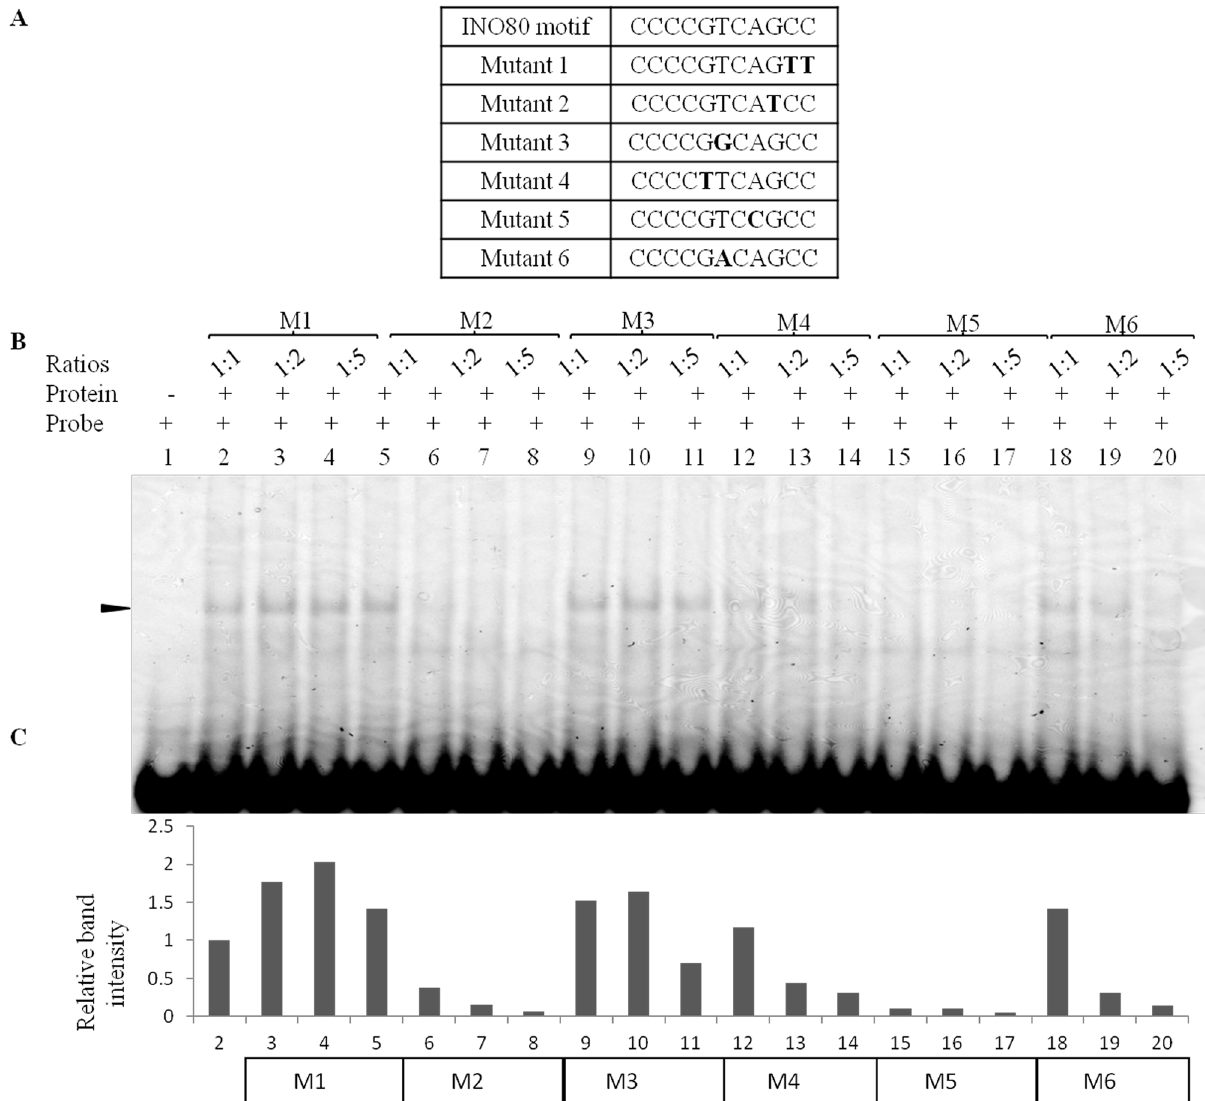
Fig 5. Competitive EMSA with the mutant oligos. (A) List of mutant oligos used in the assays, (B) Results of competitive EMSA with mutant oligos at the indicated ratio, (C) Densitometric scan of gel shown in B. The intensity value of the band (shown by arrow) in the lanes shown in (B), normalized to band at the same position in lane 2, are plotted on the Y-axis. Three different ratios for each competing oligo were used as indicated in B and the mutant sequence used is mentioned below the